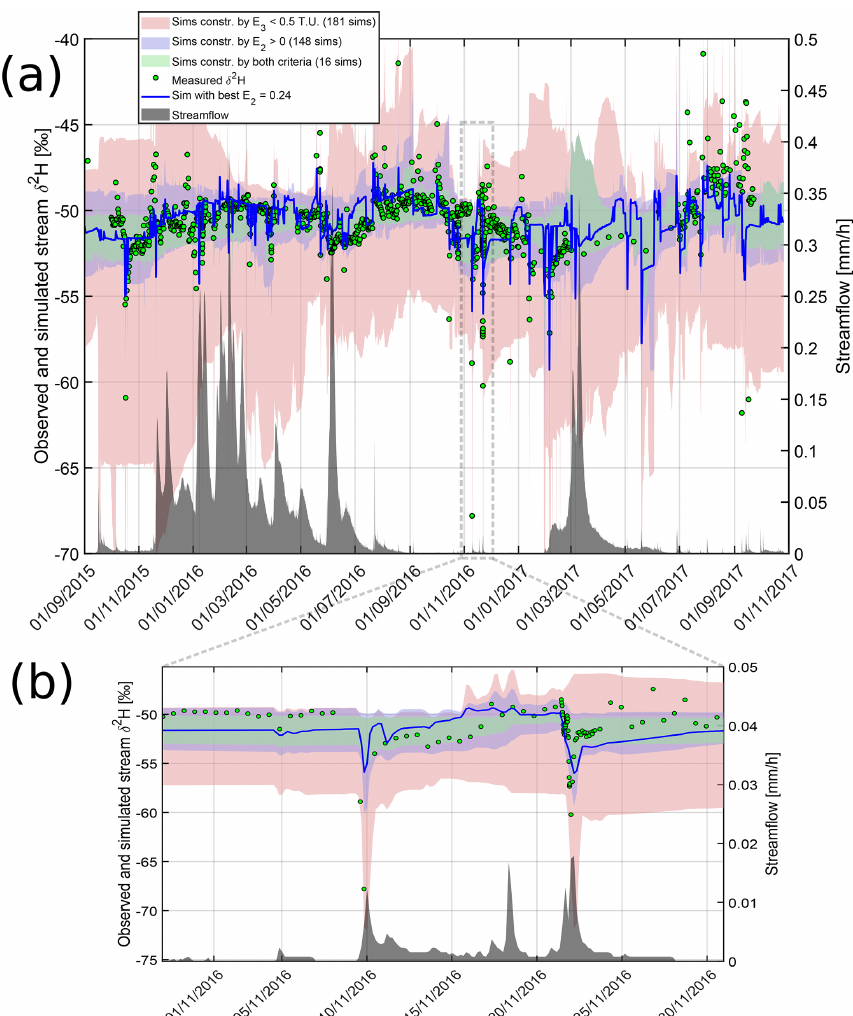
Figure 5. Simulations in deuterium. E 2 is the Nash–Sutcliffe efficiency in deuterium, and E 3 is the mean absolute error in tritium